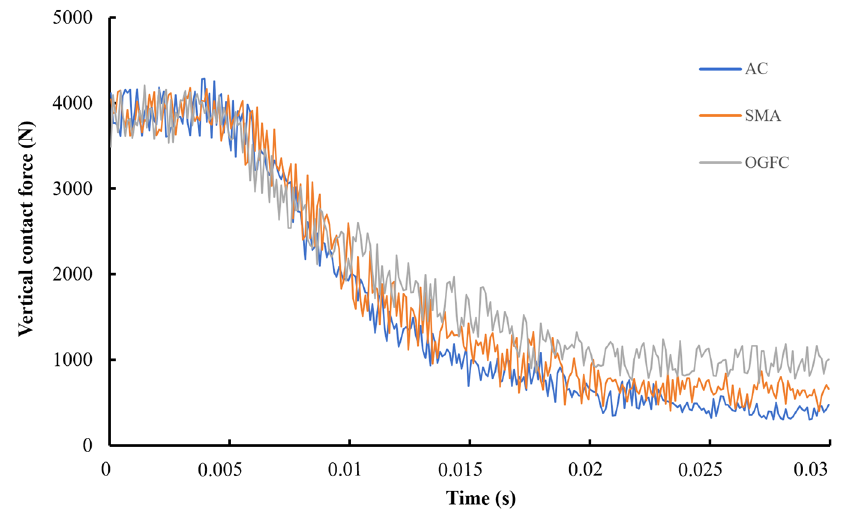
Figure 19. Effects of pavement type on vertical contact force.